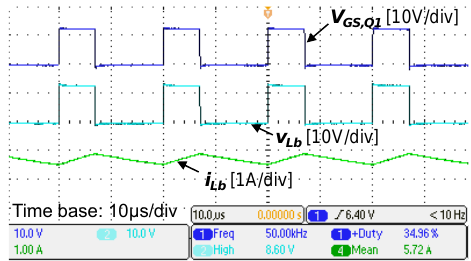
Figure 17. Voltage and current waveform of the power inductor, L b .